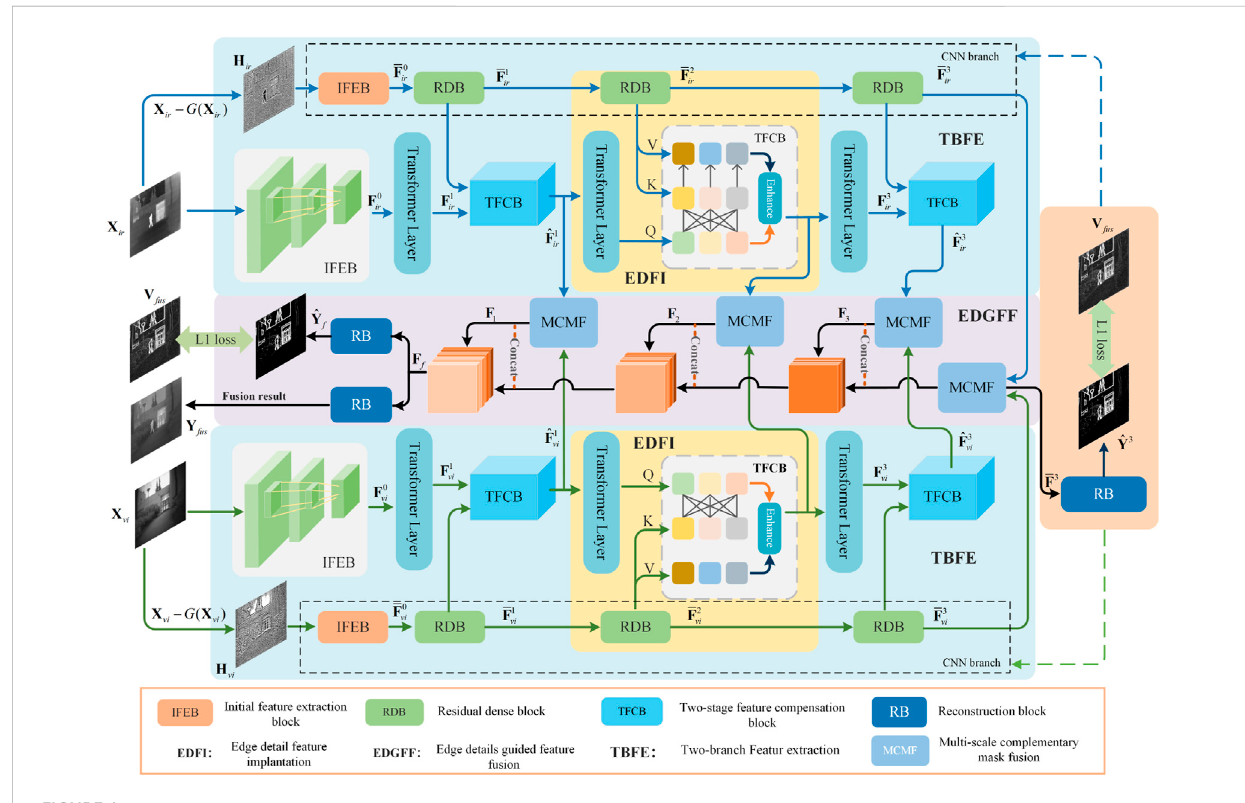
FIGURE 1 Overall framework of the proposed